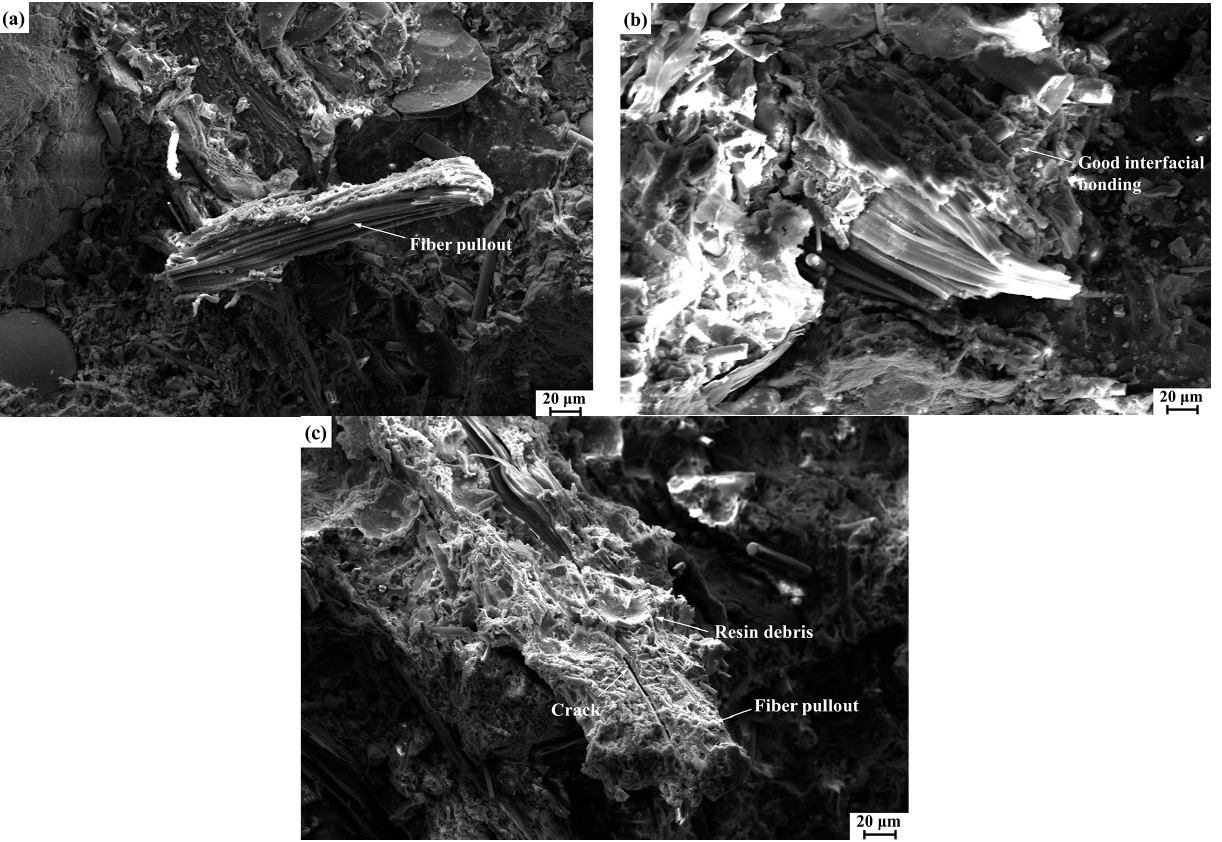
Figure 9. SEM images of the impact fracture surfaces of the composites at 6 wt.% fiber loading: ( a ) CSFC-6, ( b ) CDFC-6, and ( c ) SFC-6.